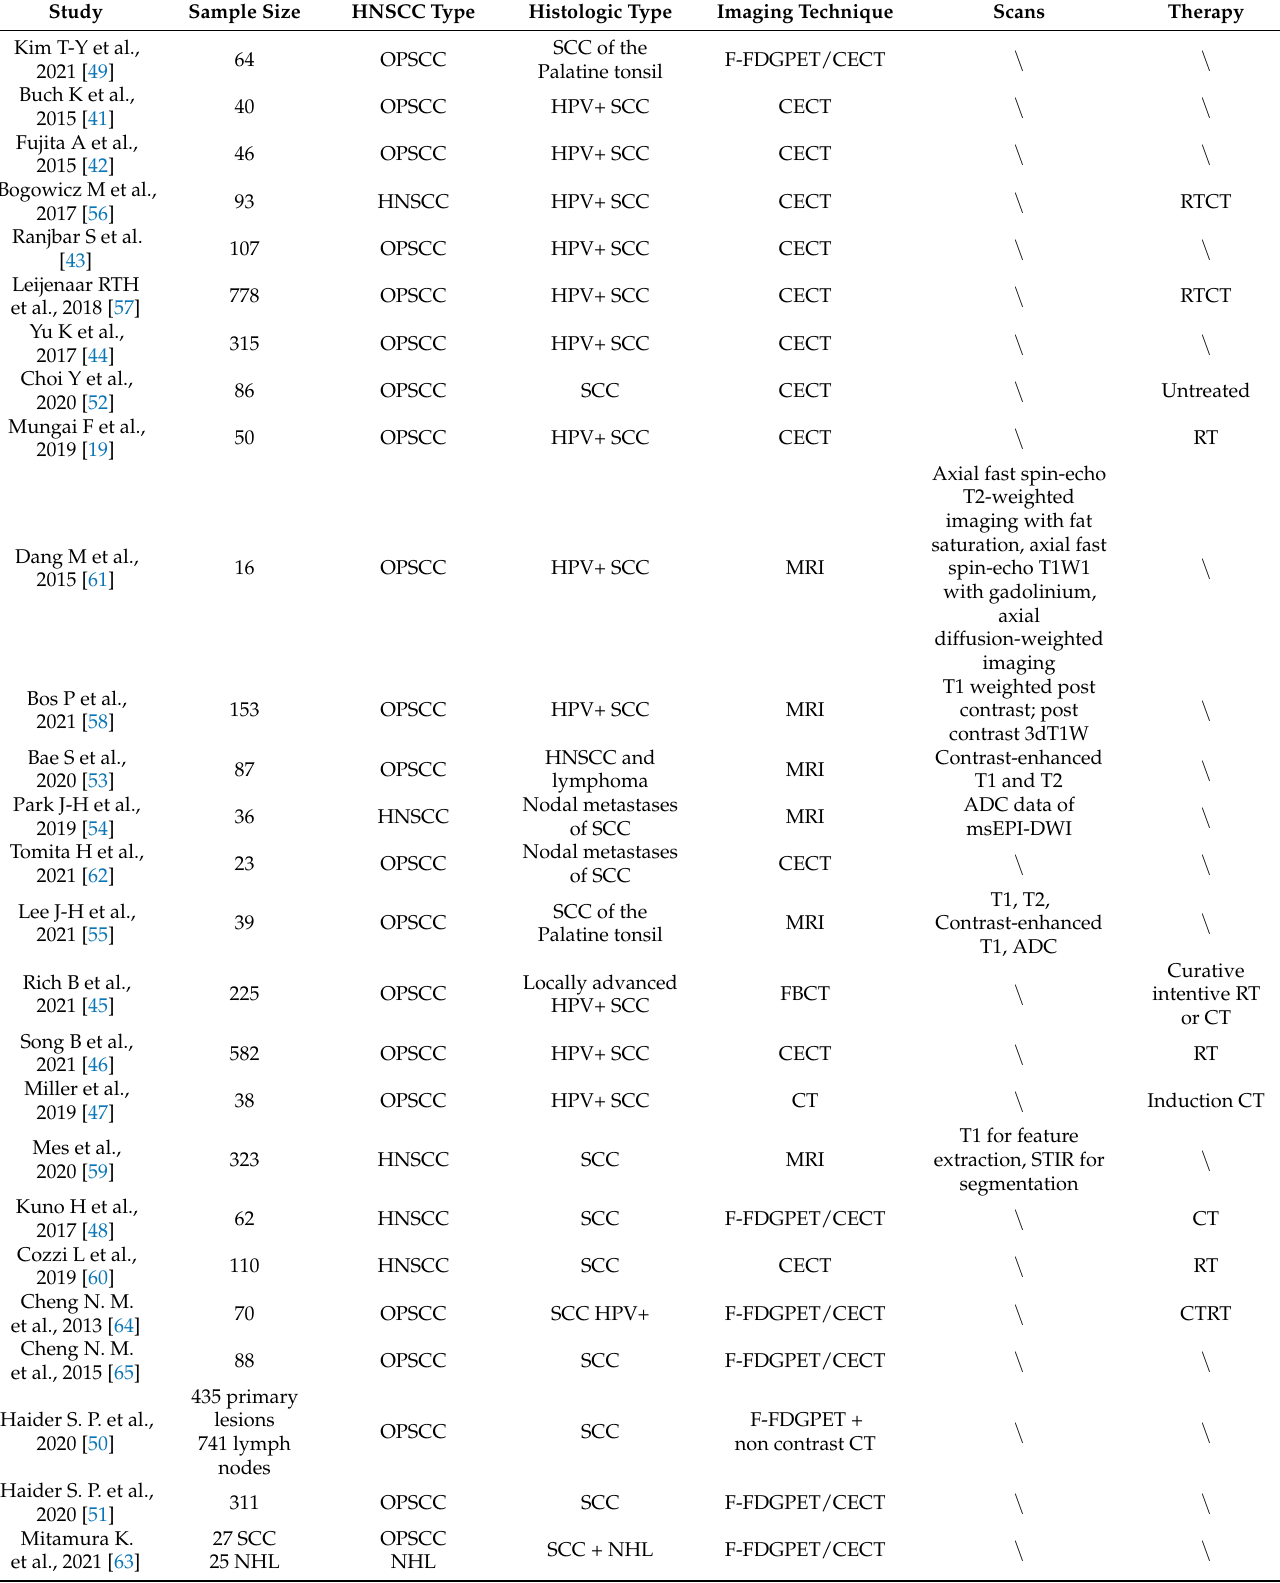
Table 2. Studies included in the systematic review. SCC: squamous cell carcinoma, HNSCC: head and neck squamous cell carcinoma, OPSCC: oropharyngeal squamous cell carcinoma, NHL: non- Hodgkin’s